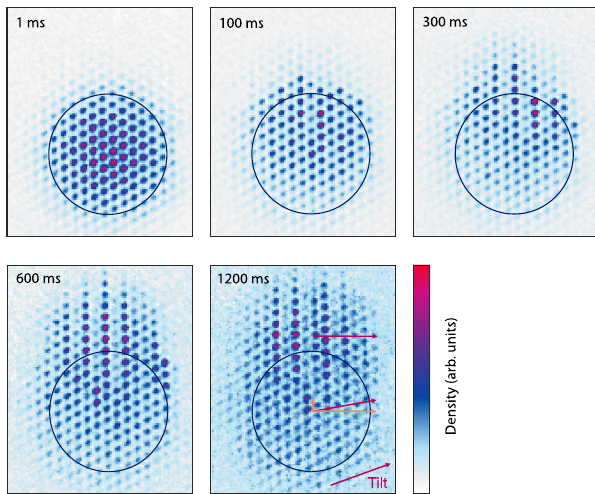
FIG. 14. Incommensurate tilt direction. Experimental images for different hold times after quenching to a tilt, which is 10 tilted against the direction perpendicular to a direct lattice vector. The red arrows indicate the local tilt direction, the orange arrows show the projection of the tilt onto a lattice vector and onto the direction perpendicular to it. A fraction of the cloud moves from the initial position (circles) to a position where the tilt is again commensu- rate (topmost arrow in the last panel) and forms a density wave with large to a small region with minimal tilt along the stripe pattern and reaches a larger contrast than in the commensurate situations discussed in the main text. This is in line with the observed relevance of coherence discussed above.